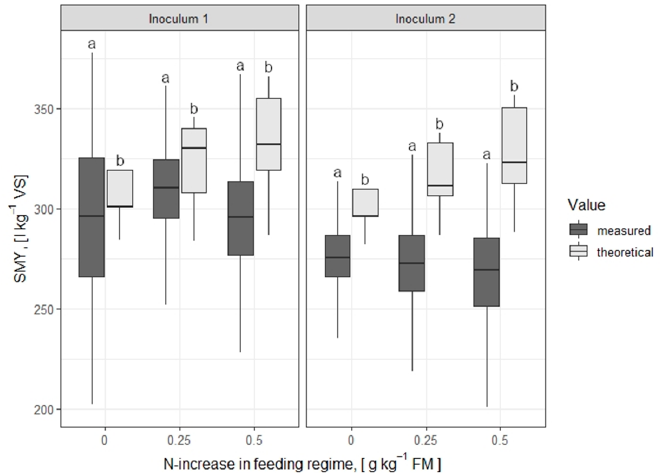
Figure 3. The results of analysis on inhibition in specific methane yield ( SMY ). The results are given separately for inoculum #1 and inoculum #2. Tick marks “0”, “0.25” and “0.5” on the x-axis correspond to the N-increase variants of “0-increase”, “0.25-increase” and “0.5-increase” in feeding regimes. The “measured” value is the measured SMY ( SMY m ); the “theoretical” value is the theoretical SMY ( SMY t ). Letters “a” and “b” denote the significant di ff erences between the SMY m and SMY t for the same variant of N-increase according to the results of the one-sided Tukey